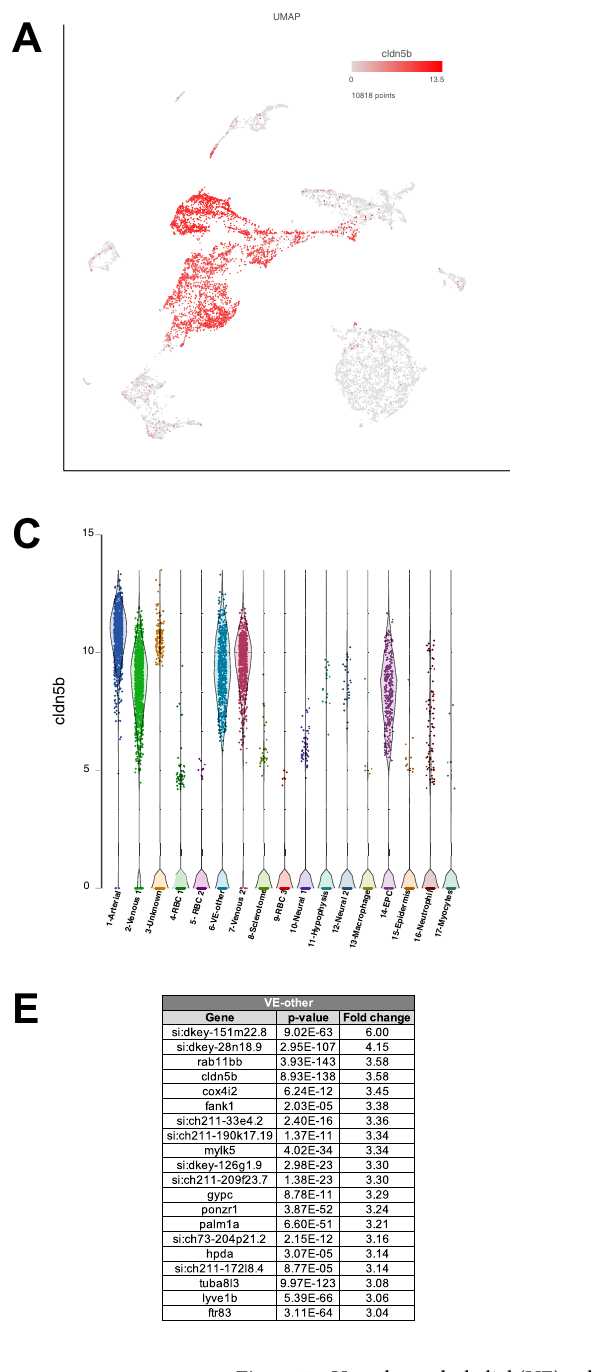
Figure 5. Vascular endothelial (VE)-other cluster #6. ( A , B ) UMAP feature plots showing expression of selected markers for cluster #6, cldn5b and dab2 . ( C , D ) Violin plots showing expression of cldn5b and dab2 in different cell populations. ( E ) List of top 20 genes differentially expressed in Vascular endothelial (VE)-other cluster. ( F ) List of top 20 pathways enriched in Vascular endothelial (VE)-other